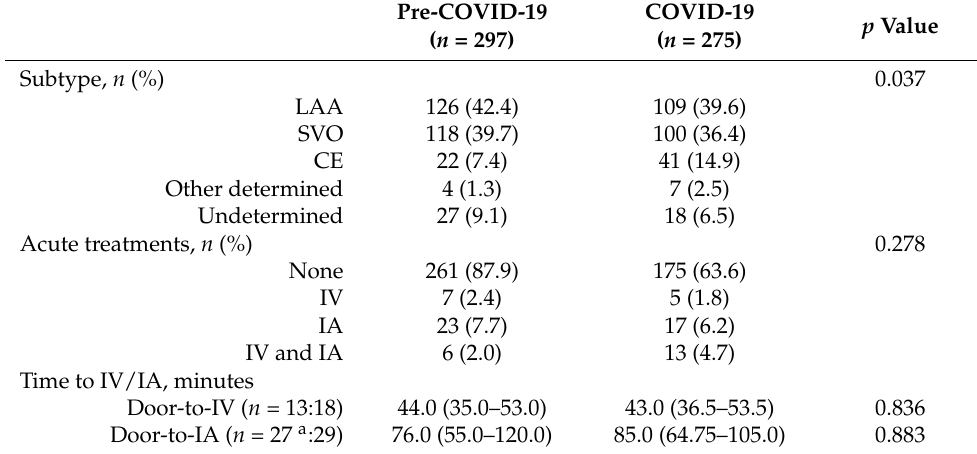
Table 2. Features of ischemic stroke cases recorded during the COVID-19 and pre-COVID-19 pandemic